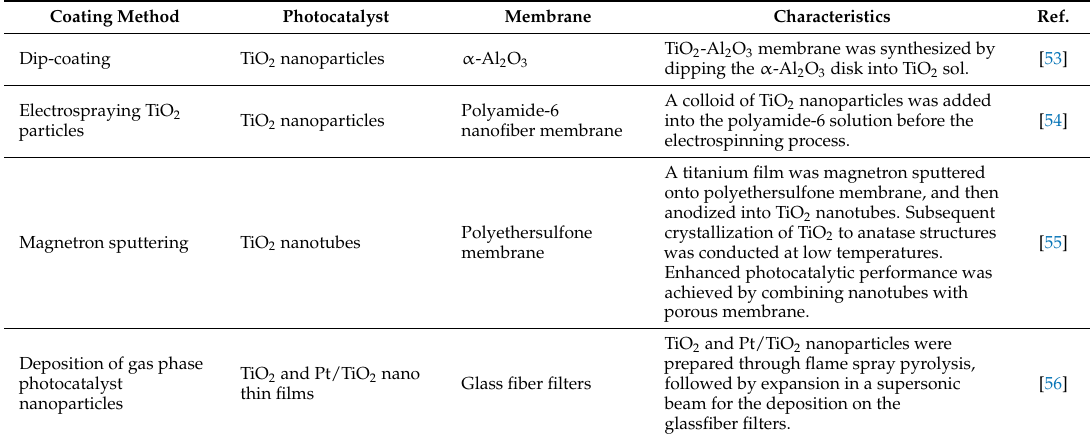
Table 1. Examples of membranes coated with photocatalyst by different